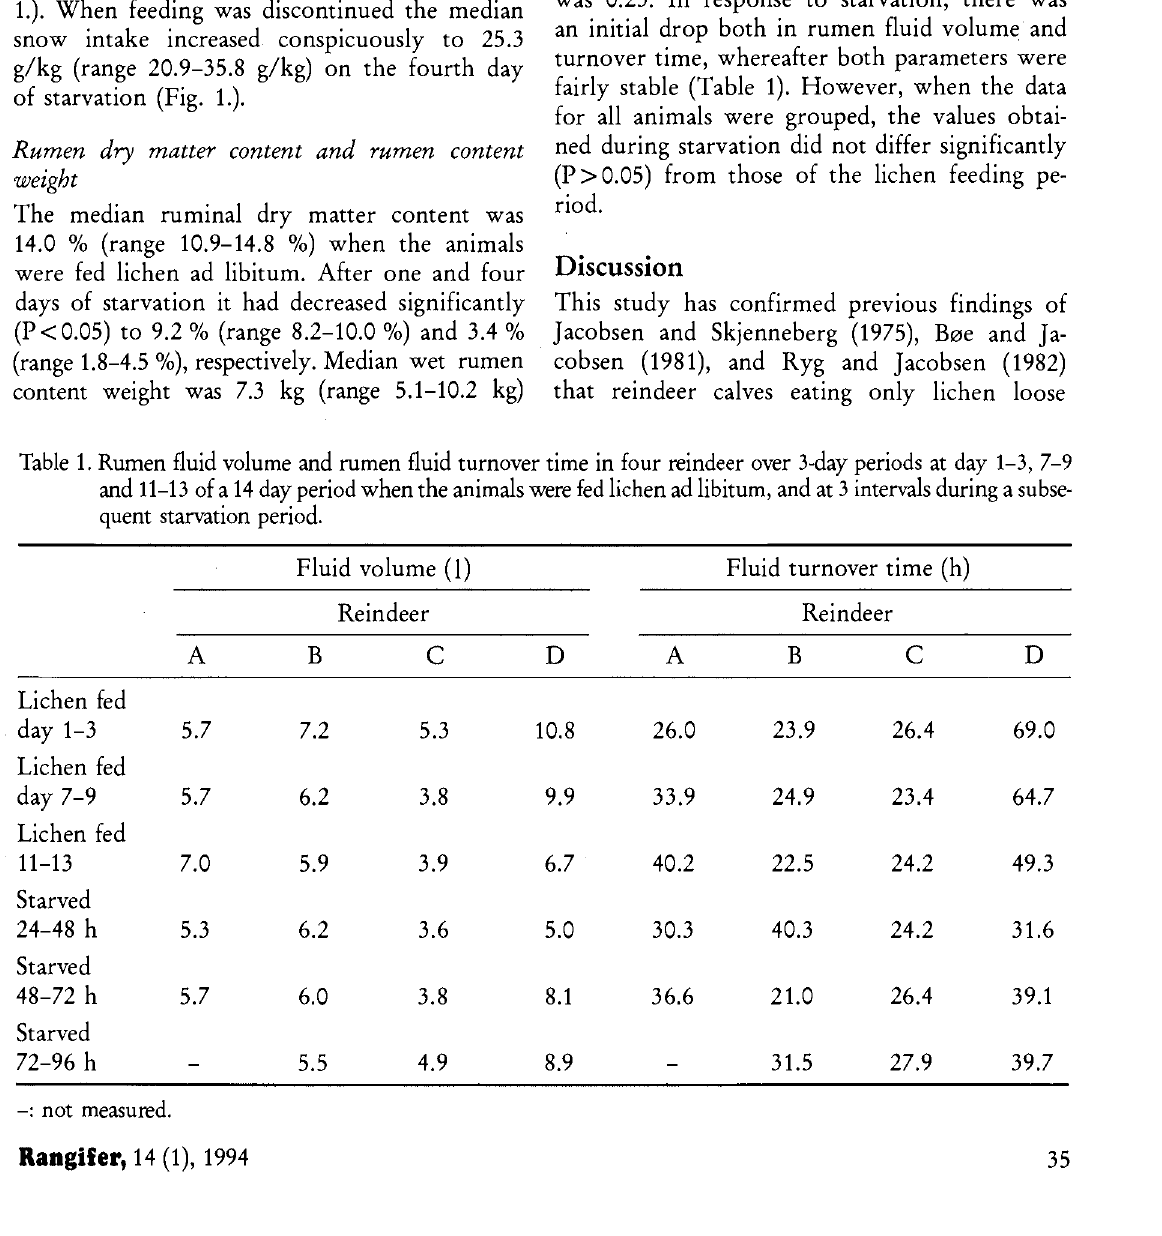
Table 1. Rumen fluid volume and rumen fluid turnover time in four reindeer over 3-day periods at day 1-3, 7-9 and 11-13 of a 14 day period when the animals were fed lichen ad libitum, and at 3 intervals during a subse quent starvation